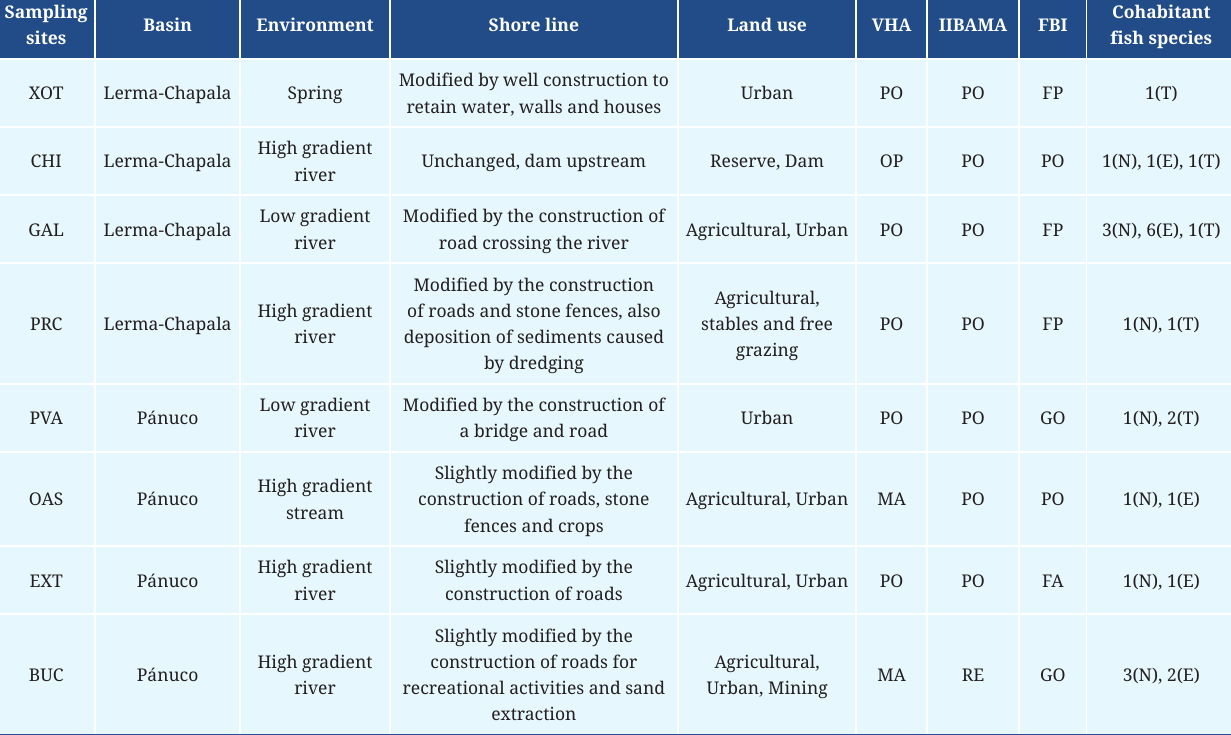
TABLE 1 | Environmental heterogeneity gradient including basin, land use, shore line and Visual-based Habitat Assessment (VBHA), Index of Biological Integrity Based on Aquatic Macroinvertebrates Assemblages (IIBAMA) and Family-level Biotic Index (FBI) categories. For VHA: Poor =PO; Suboptimal =SO; and Optimal=OP. For IIBAMA: Poor=PO; and Regular=RE. For FBI: Fairly Poor=FP, and Fair=FA. For species: Native species=N; Exotic species=E; and Translocated species=T. XOT=El Xote; GAL=Los Galvanes; CHI= El Charco del Ingenio; PVA=Paso